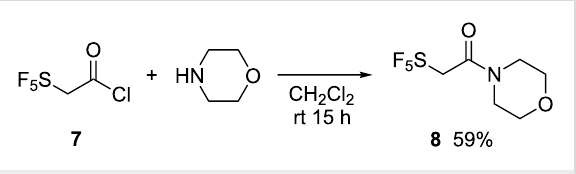
Scheme 5: Synthesis of SF 5 -substituted acetmorpholide 8